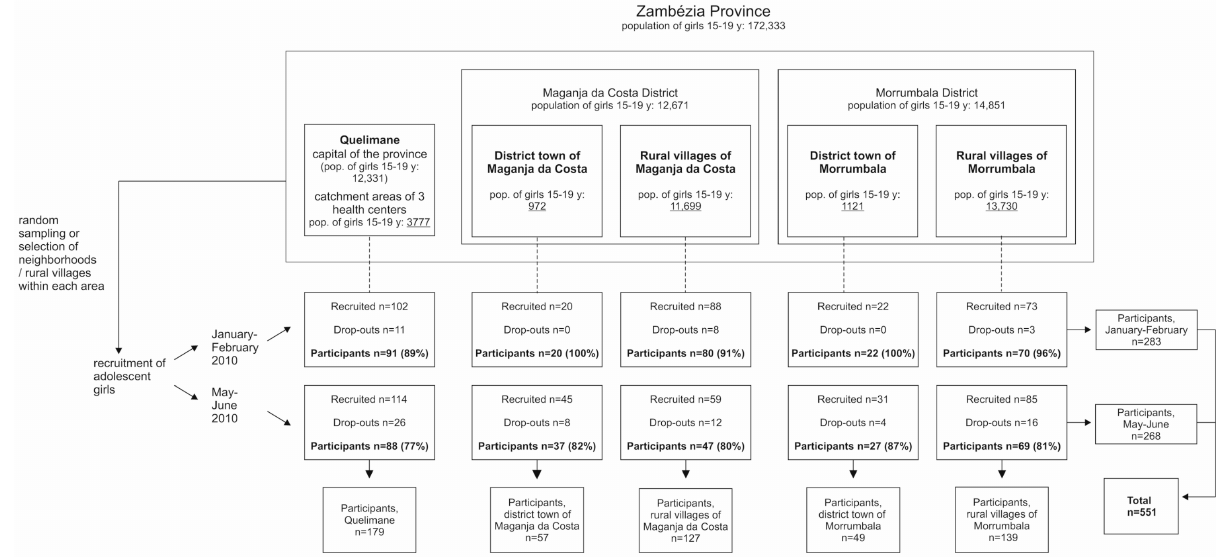
Figure 2. Implemented sampling design. The population figures are from the 2007 Census.